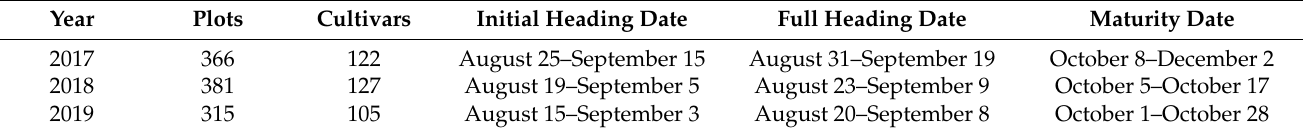
Table A1. Statistics of phenological dates after transplanting across rice cultivars.